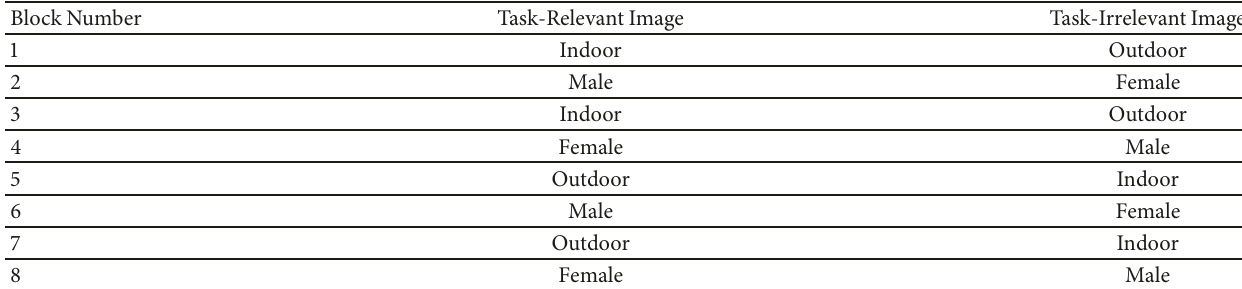
Table 2: The task-relevant and task-irrelevant images for each block a sample sequence of trials.